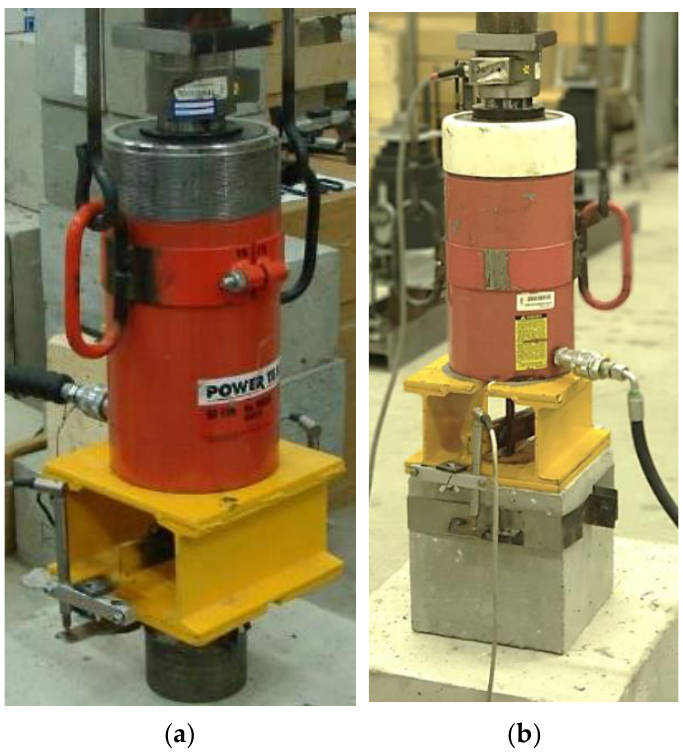
Figure 7. ( a ) Test with a steel base specimen; ( b ) Test with a concrete base specimen.